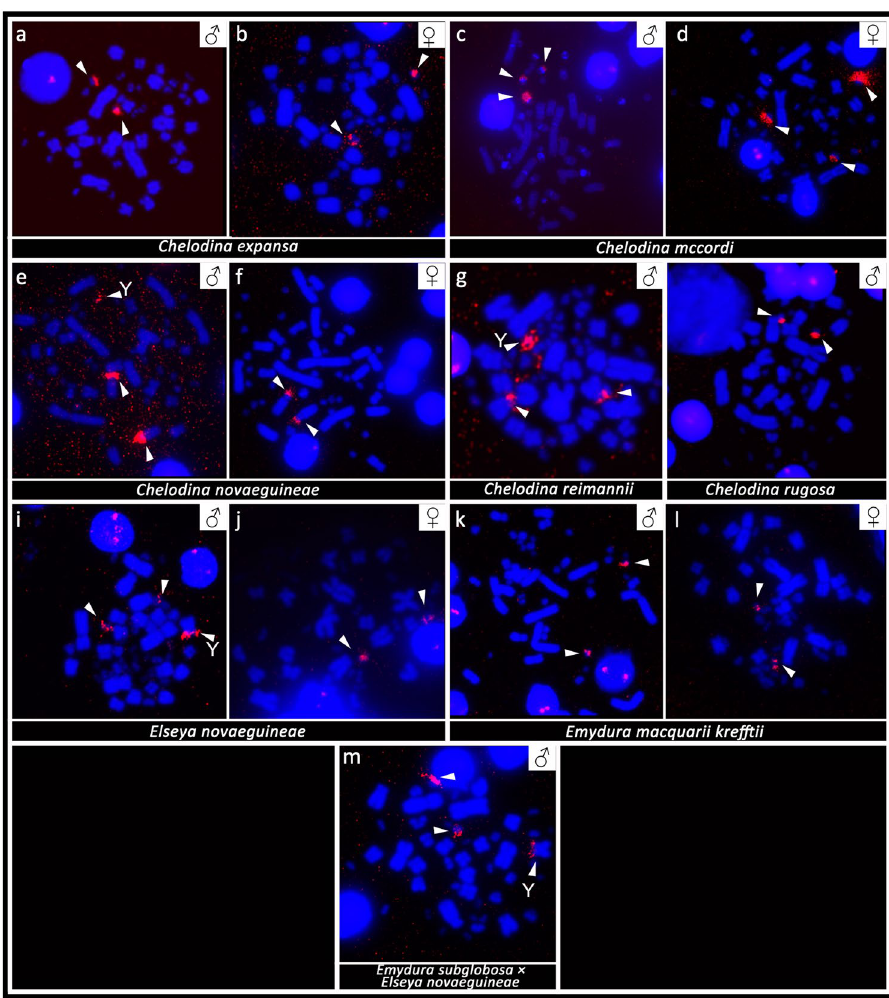
Figure 2. In situ hybridization with probe specific for the rDNA sequence in Chelodina expansa ( a,b ), Chelodina mccordi ( c,d ), Chelodina novaeguineae ( e,f ), Chelodina reimanni ( g ), Chelodina rugosa ( h ), Elseya novaeguineae (i,j ), Emydura macquarii krefftii ( k,l ), and the hybrid Em. subglobosa × El. novaeguineae ( m ). The FITC signal was pseudocolourized in red. All metaphases were counterstained with DAPI (blue). The Y chromosome is indicated with a white